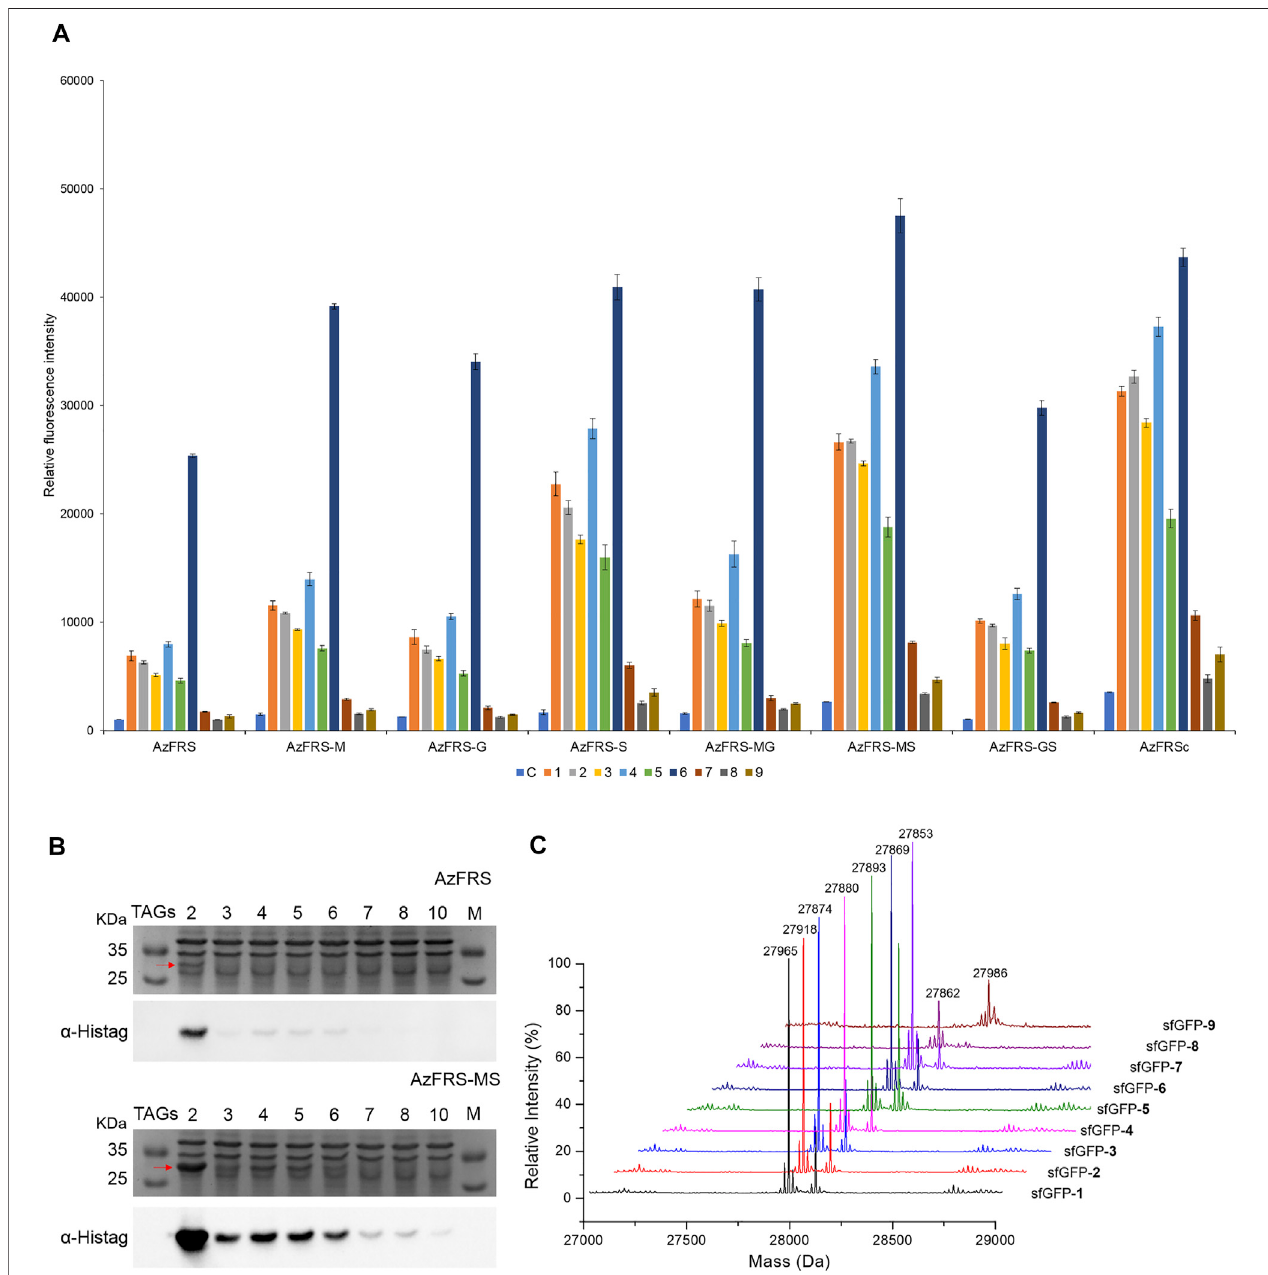
FIGURE3| sfGFPproduction,ambersuppressionef fi ciency,andmasscharacterizationobtainedfromAzFRSvariants. (A) Theincorporationef fi cienciesofAzFRS variants ( Table 1 ) are determined by the fl uorescence emission intensities obtained from sfGFP-27am gene products, respectively. Proteins are expressed after supplemented with 1 mM ncAA and IPTG in GMML medium at 37 ° C for 12 h. Cells are excited at 485 nm, and the fl uorescence emission intensities are recorded at 535 nm.Thecelldensityismonitored throughtheUVabsorbanceat595 nm.Cdenotesthecontrolexperimentthatcellssupplementedwith1 mMIPTGonly; 1 – 9 denotetheexperimentssupplementedwith1 mMIPTGandncAAs 1 – 9 ( Scheme1 ).ThebackgroundsignalobtainedfromcellswithoutaddingIPTGissubtractedfrom the signal obtained from each group. Error bars represent the standard deviation of sfGFP production from three repeated experiments. (B) Tandem amber codon (cid:129) (cid:129) suppression ef fi ciency analysis for sfGFP production by AzFRS tRNA Pyl and AzFRS-MS tRNA Pyl pairs. Amber suppression of sfGFP-2ams ∼ 8ams and sfGFP-10ams genes, containing suppression of 2 ∼ 10 TAG stop codons, produces full-length sfGFP proteins with the incorporation of multiple 4 . The sfGFP proteins are (cid:129) (cid:129) overexpressedin E.coli BL21(DE3)codingAzFRS tRNA Pyl orAzFRS-MS tRNA Pyl pairsupplementedwith1 mMIPTGand1 mM 4 inGMMLmediumat37 ° Cfor12 h. The whole-cell lysate is analyzed by SDS-PAGE and Westernblotting against the anti-Histagantibody (indicated as α -Histag).Thered arrow indicates thesfGFP protein band on the SDS-PAGE. The SDS-PAGE and Western blotting analysis are shown in Supplementary Figures S1, S2 ; (C) Mass determination of sfGFP-27am gene (cid:129) productscoupledwithncAAs 1 – 9 byESI-MS.Thefull-lengthsfGFP- 1 – 9 proteinsareoverexpressedbytheAzFRS-MS tRNA Pyl pairin E.coli BL21(DE3)supplemented with 1 mM IPTG and 1 mM ncAAs 1 – 9 in GMML medium at 37 ° C for 12 h. The calculated and observed molecular masses of sfGFP- 1 – 9 are found in Table 2 . The detailed electrospray and deconvoluted mass spectrum are shown in Supplementary Figures S3 – S11 .